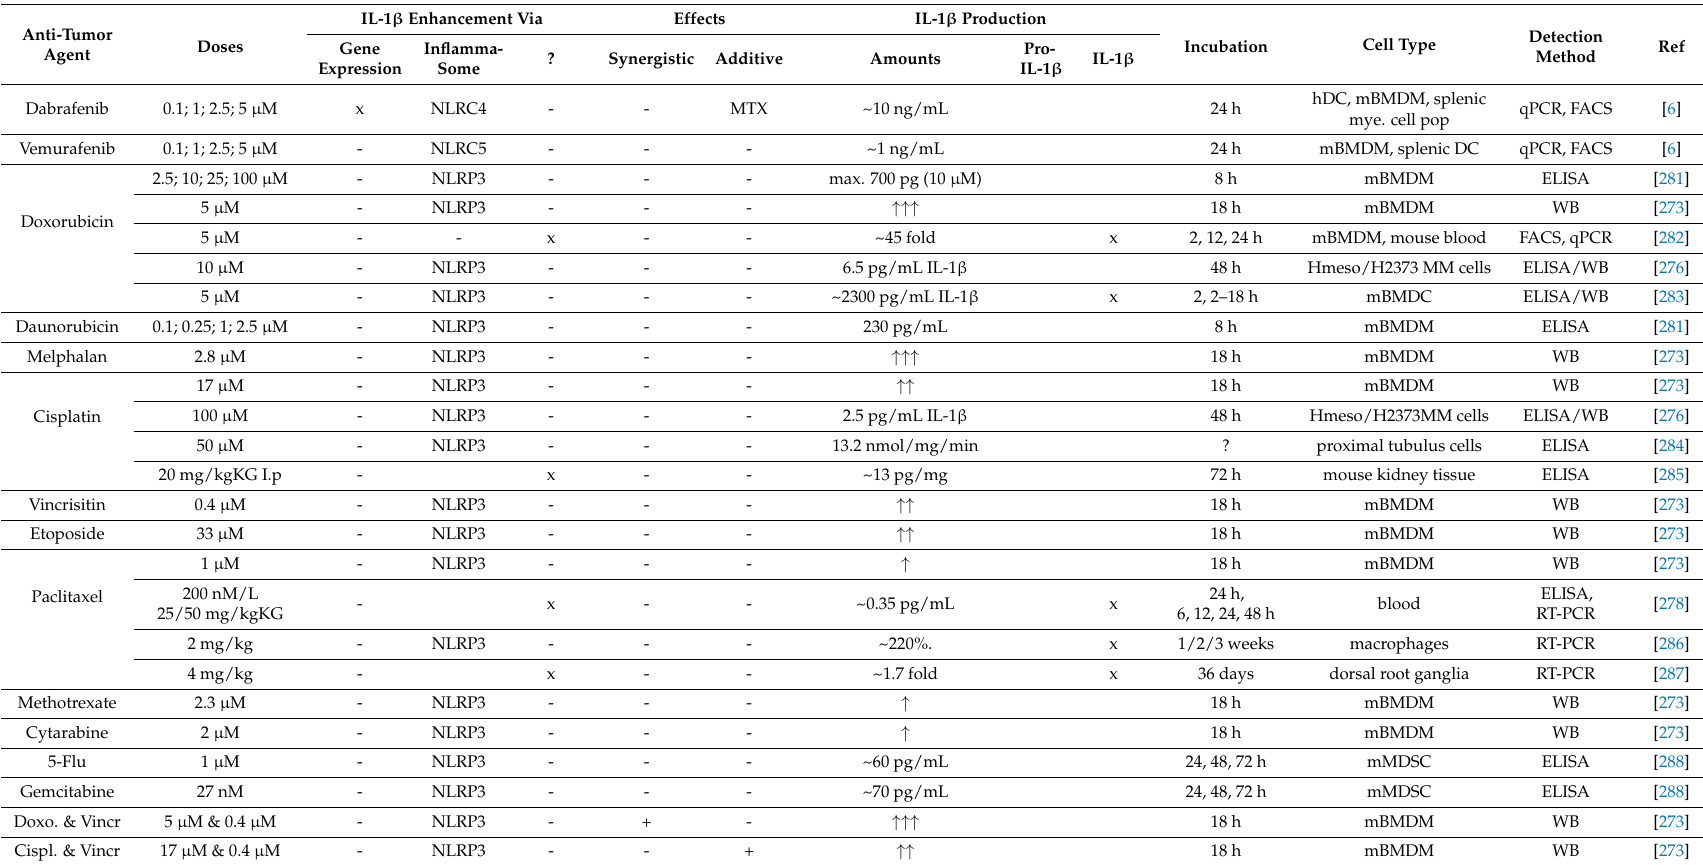
Table 1. Anti-tumor drugs that induce IL-1 β